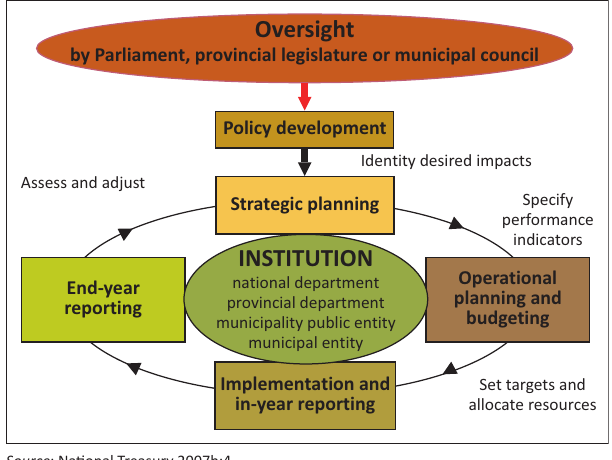
FIGURE 1: Planning, budgeting and reporting